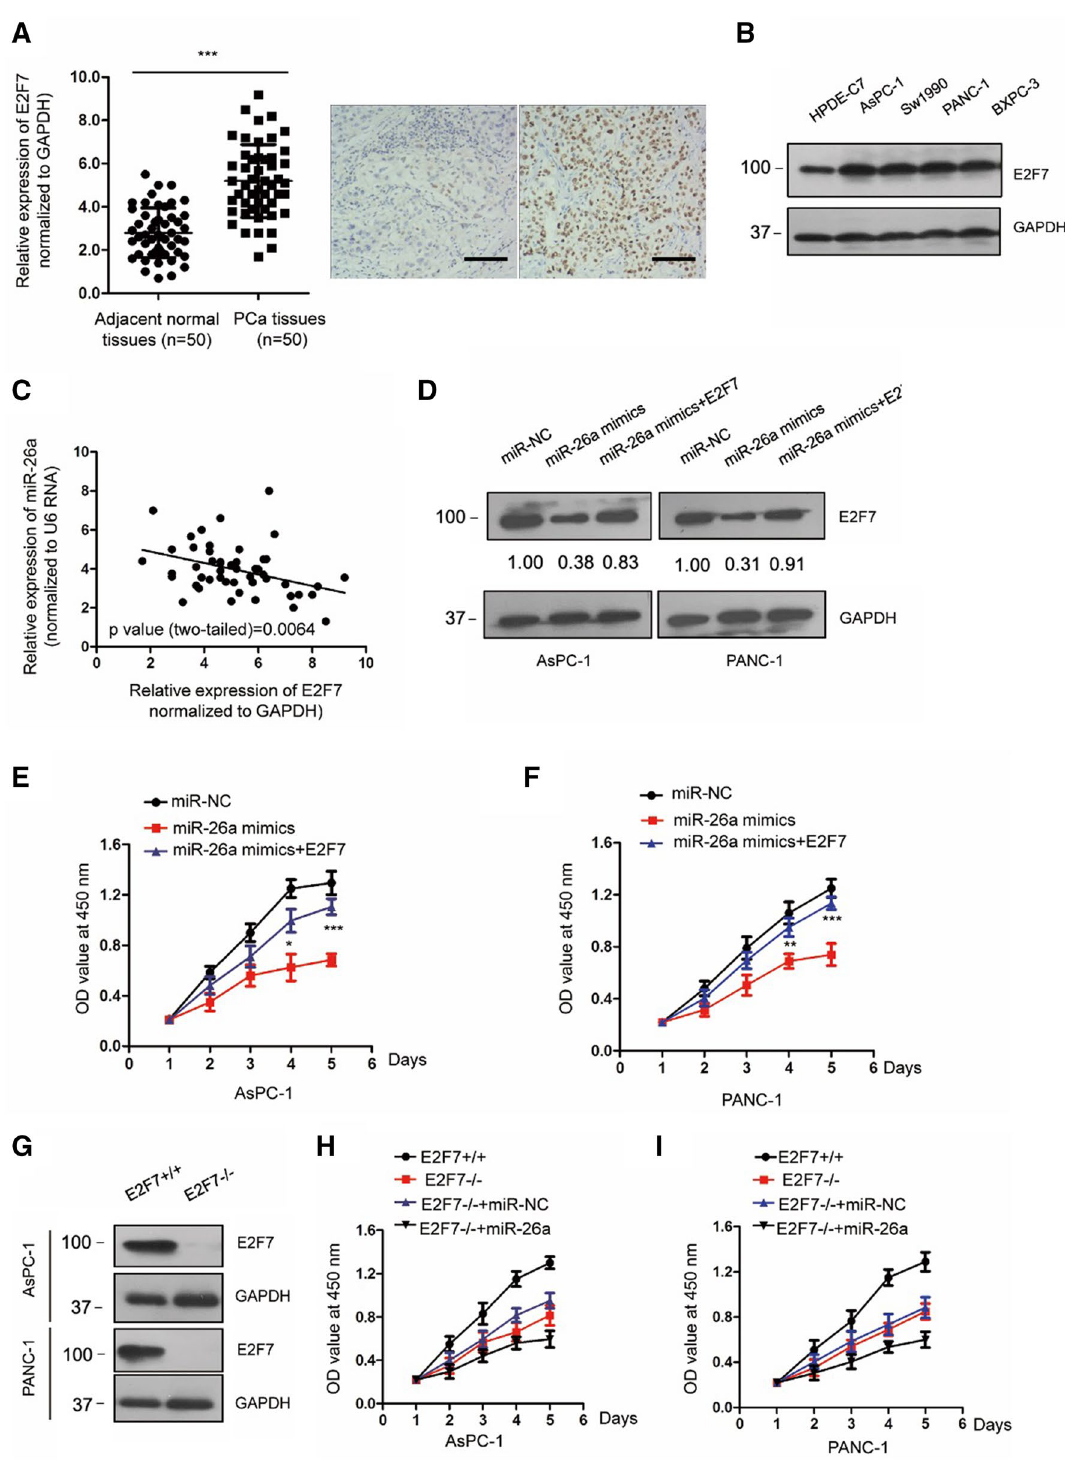
Fig. 4 Overexpressed E2F7 in PCa attenuated the suppressive role of miR-26a. A E2F7 mRNA levels in the indicated tissues samples were detected using RT-qPCR. The representative IHC staining of VEGFA in PCa tissues and adjacent normal tissues. Scale bar, 50 um. B The pro- tein levels of E2F7 in normal and PCa cells were compared by Western blot. C Spearman correlation test showed the inverse correlation between miR-26a and E2F7 in PCa. D We transfected PCa cells with the indicated vectors and detected E2F7 expression. E , F Reintroduction of E2F7 significantly reversed the suppressed proliferation by miR-26a. G The endogenous level of E2F7 was knocked out by Caspir-cas9, and the silencing efficiency was confirmed via Western blotting. H , I Silencing of E2F7 expression further inhibited PCa cell proliferation by miR-26a overexpression. * P < 0.05, ** P < 0.01, and *** P <